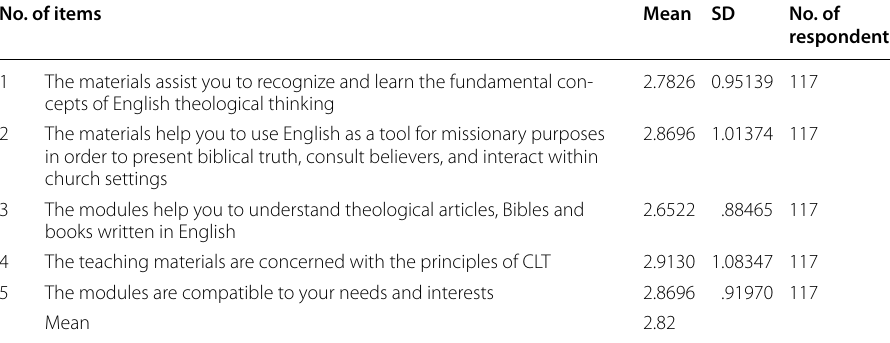
Table 3 Perception of theology students on the current ELT